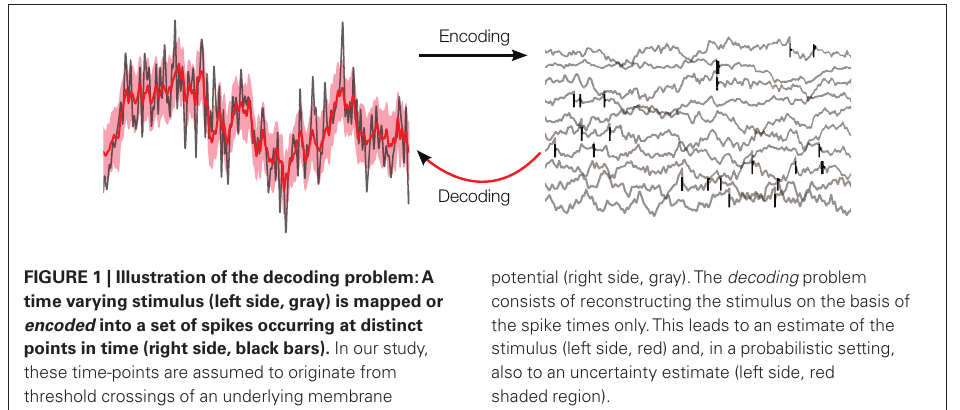
Figure 1 | illustration of the decoding problem: A time varying stimulus (left side, gray) is mapped or encoded into a set of spikes occurring at distinct points in time (right side, black bars). In our study, these time-points are assumed to originate from threshold crossings of an underlying membrane